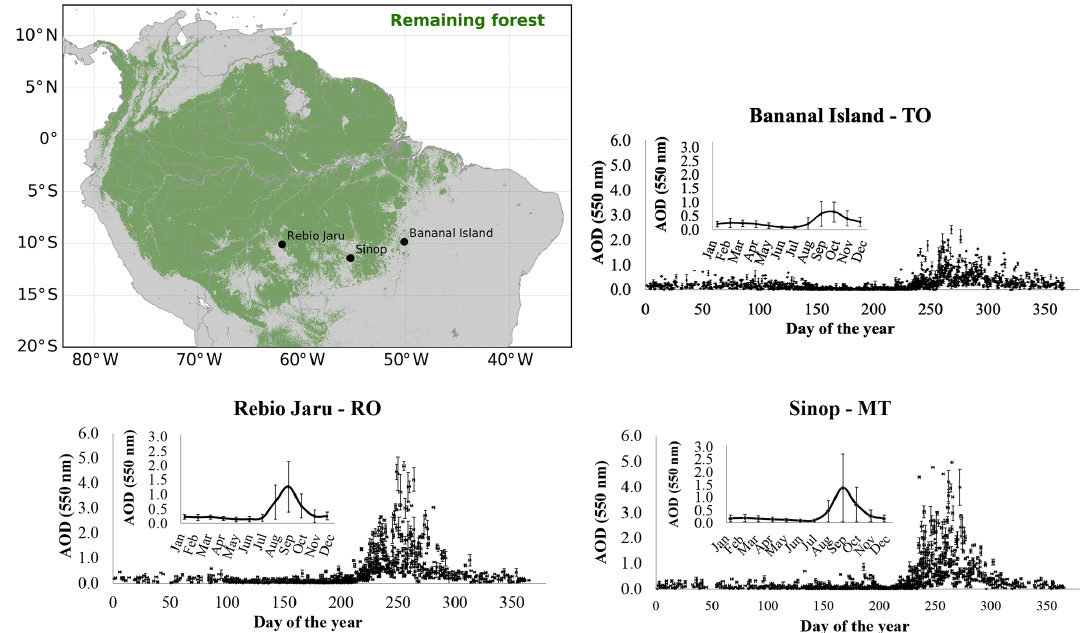
Figure 1. Geographical representation of the northern region of Brazil. The darker green area represents remaining forest. The black dots indicate the location of the study sites: Rebio Jaru, RO (west), Sinop, MT (center), and Bananal Island, TO (east). Boxes show the temporal distribution of the aerosol optical depth at 550nm over the three sites derived from MODIS from 2003 and 2008 and the monthly mean values for the period, with the standard deviation represented by vertical